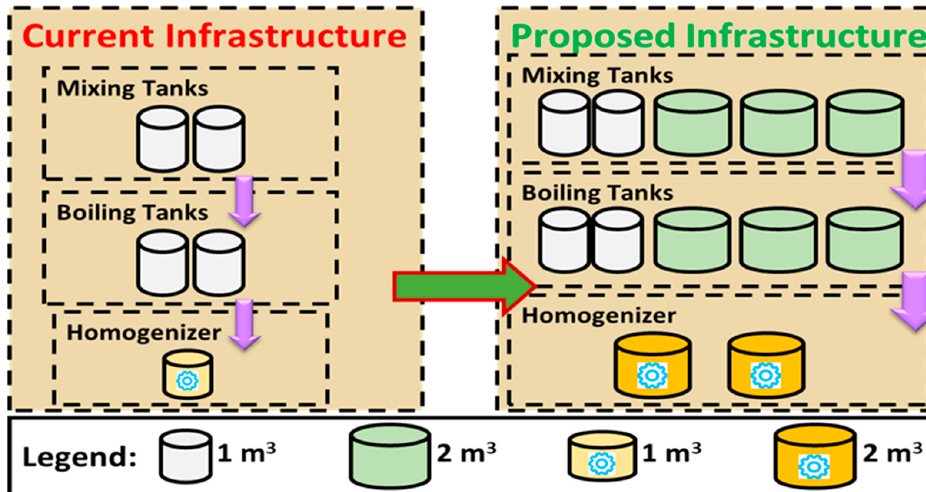
Figure 14. Production Section Layout.